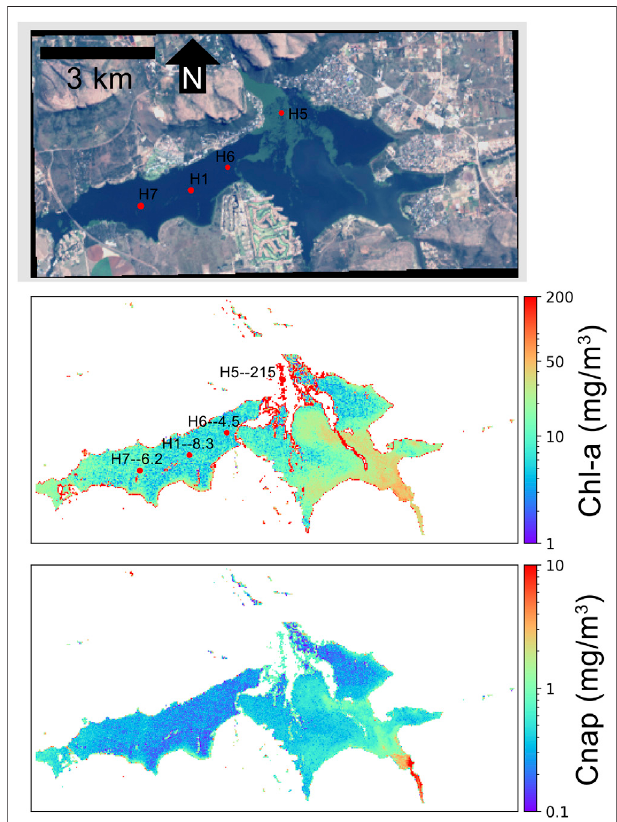
FIGURE 8 | MLP product retrievals over Hartbeespoort Dam on March 29, 2017 using L8 TOA re fl ectance data. For the chl-a panel, in-situ sampling points (red dots) are labeled with the station name followed by the measured quantity of chl-a, in units of mg/m 3 . In-situ data are from Kravitz et al.